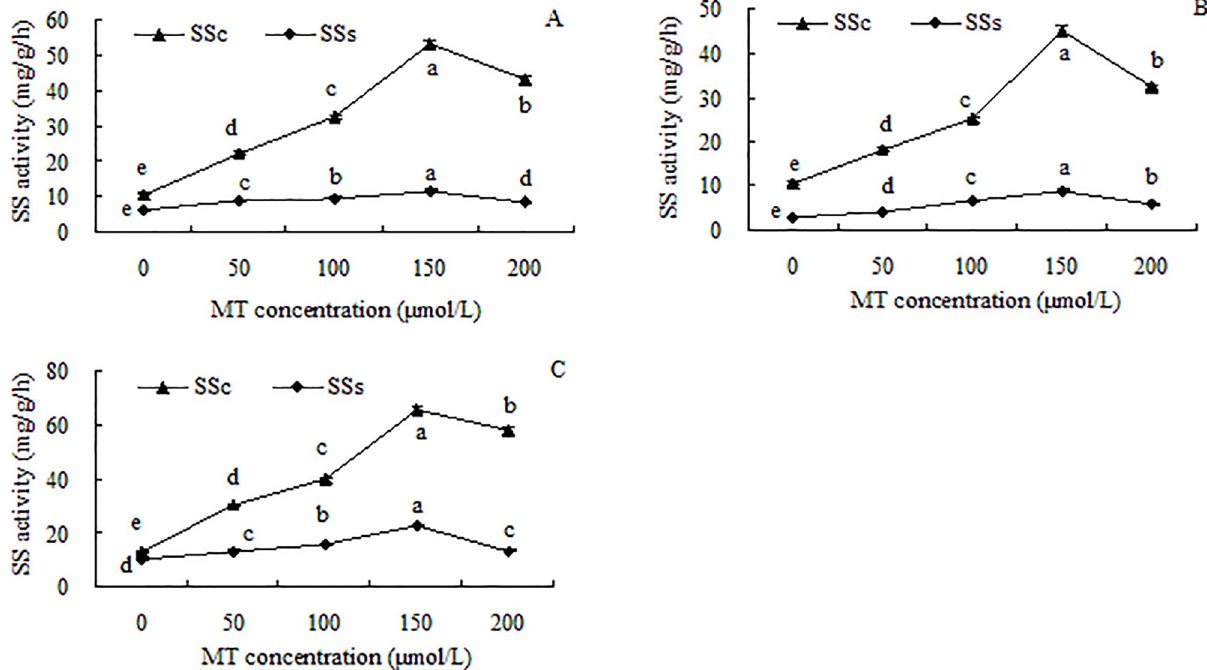
Fig 4. Sucrose synthase (SS) activities in roots (A), stems (B), and leaves (C) of grape seedlings. Different lowercase letters indicate significant differences based on one-way analysis of variance followed by least significant difference test ( p � 0.05). SSc = sucrose synthase in cleavage direction; SSs = sucrose synthase in synthetic direction.